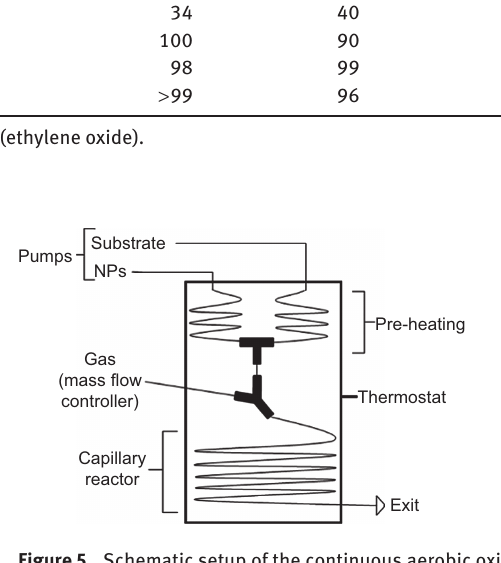
Figure 5 Schematic setup of the continuous aerobic oxidation of benzyl